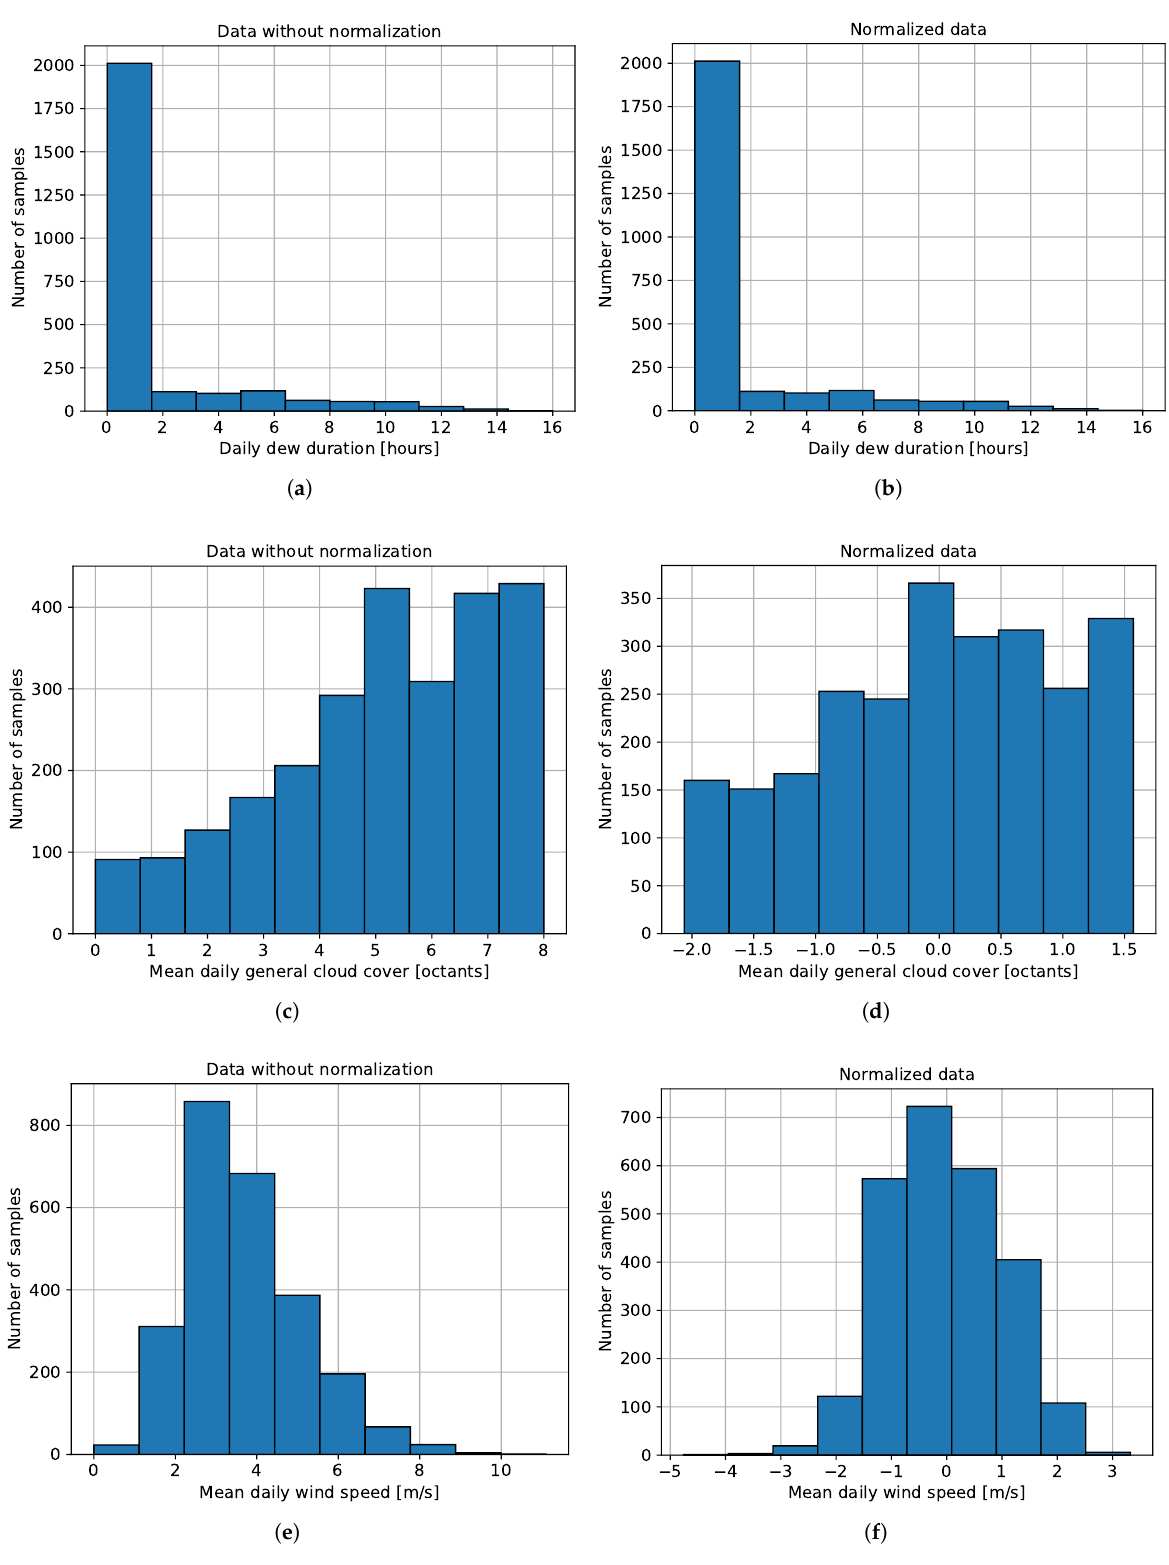
Figure A3. Input data histograms (daily dew duration before ( a ) and after normalization ( b ), mean daily general cloud cover before ( c ) and after normalization ( d ), and mean daily wind speed before ( e ) and after normalization ( f